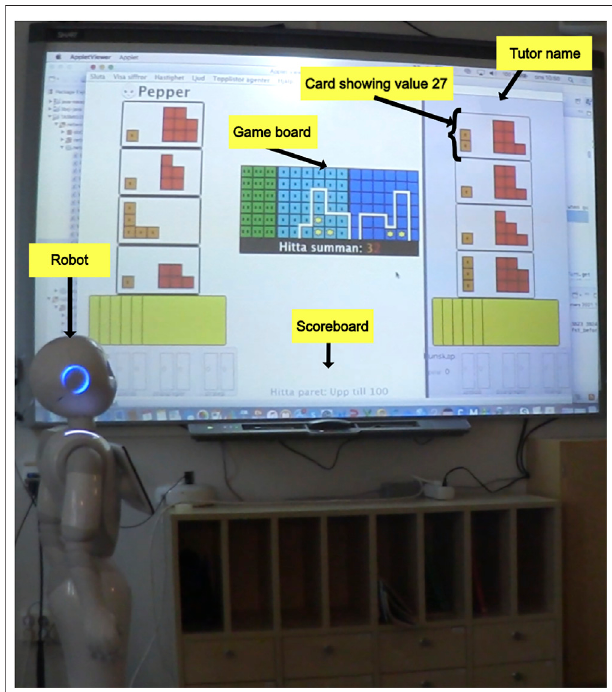
FIGURE 1 | The START System showing the card hands and visible cards for the tutee and tutor on the left- and right-hand side, respectively. The tutor name has been redacted to preserve the participant ’ s